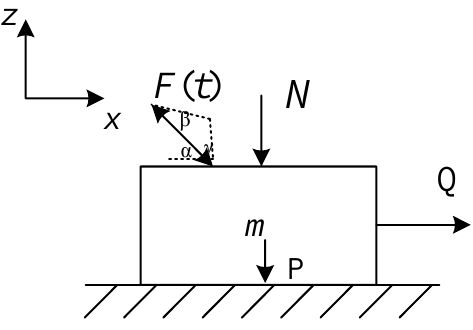
Figure 6. Vibration force projects in the second and the fourth quadrants.